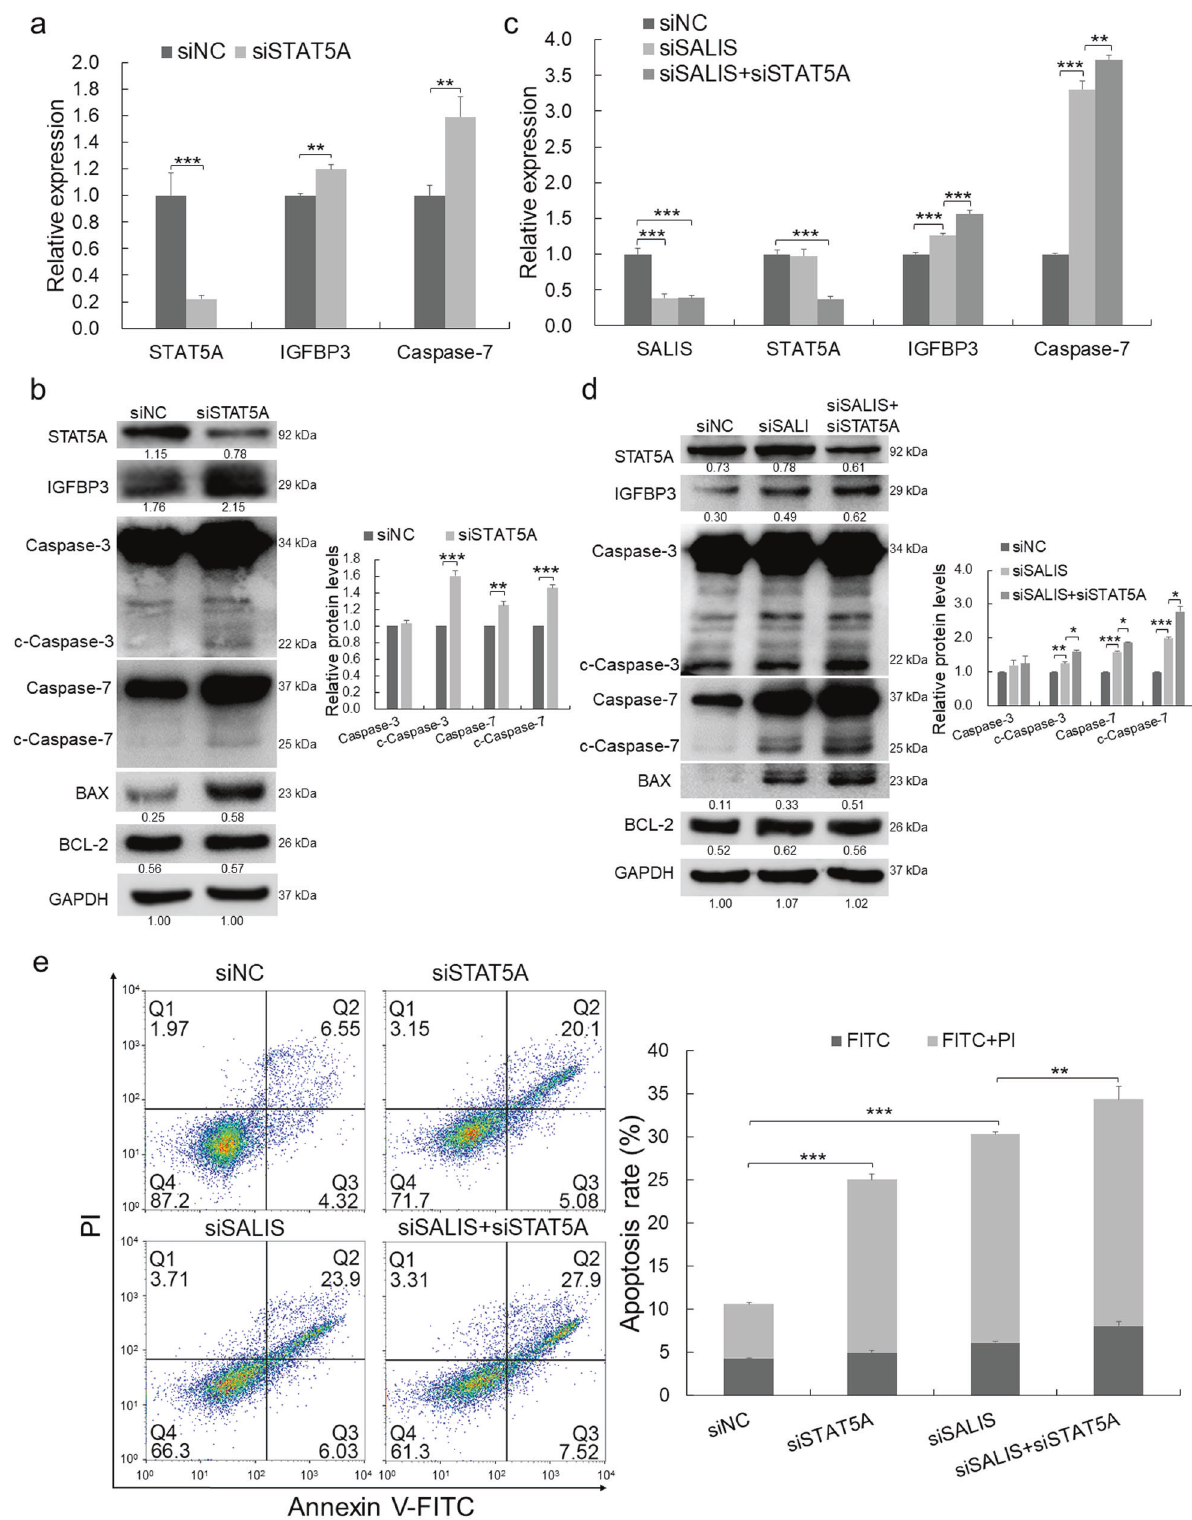
ChIP assays demonstrated SALIS-STAT5A complex directly bound to the promoter regions of IGFBP3 and Caspase-7 genes to suppress apoptosis in HCC. Thus, our results are consistent with previous studies showing the involvement of STAT5A in apoptosis in